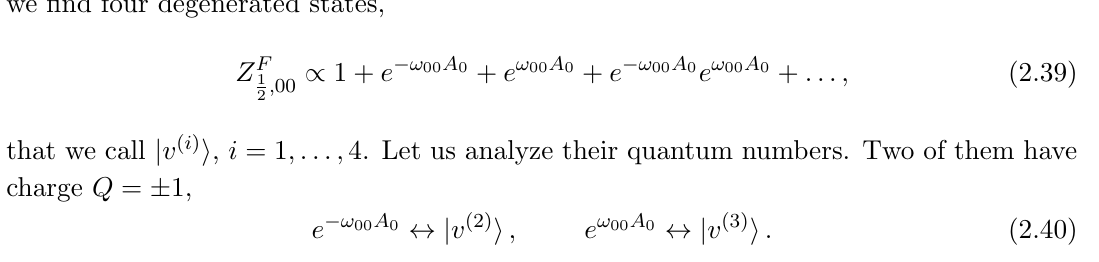
under addition of half (cid:13)uxes, V 1 = 2 (cid:11) 0 ;(cid:11) 1 (cid:11) 2